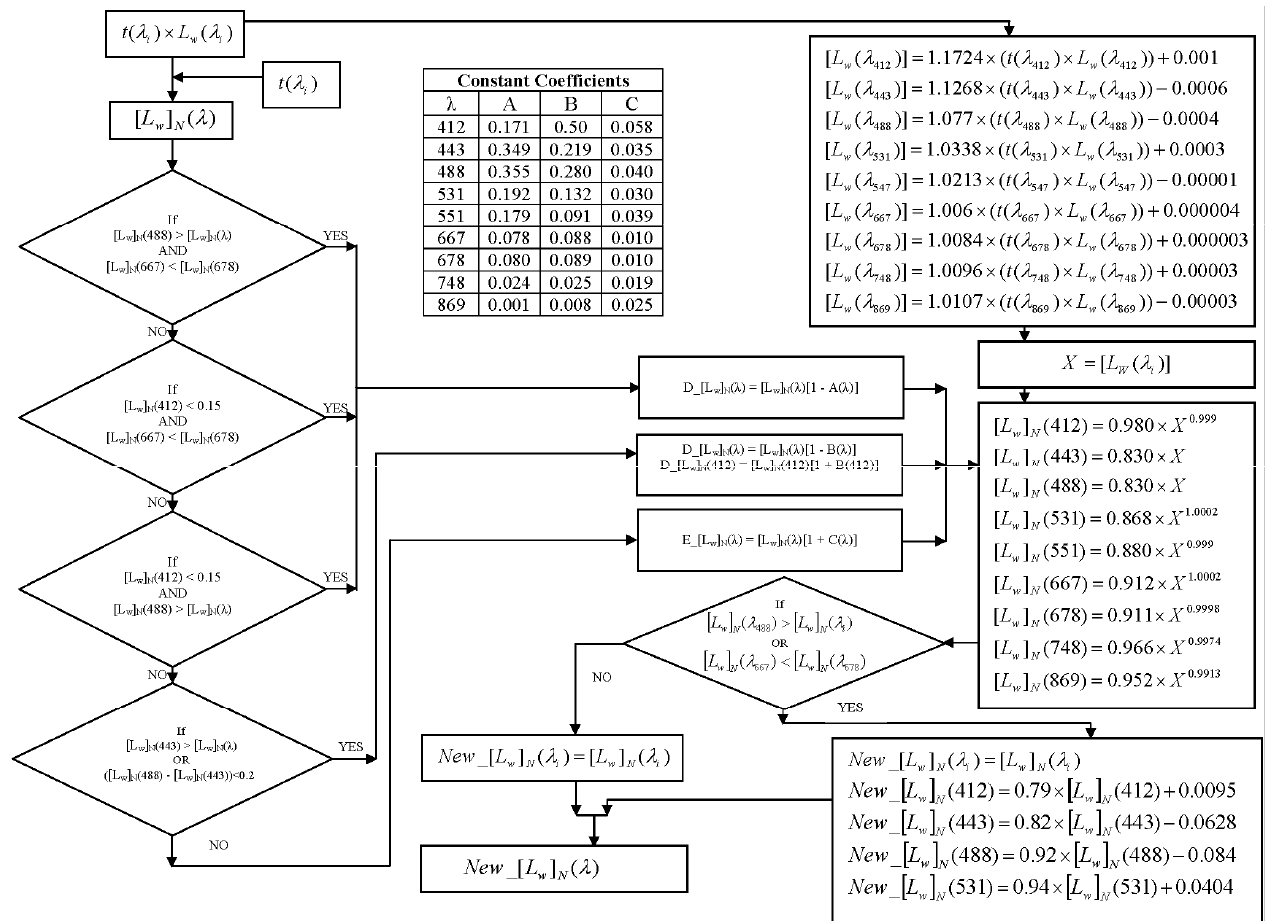
Fig. 1. Schematic representation of an iterative spectral matching scheme of the CAAS algorithm.